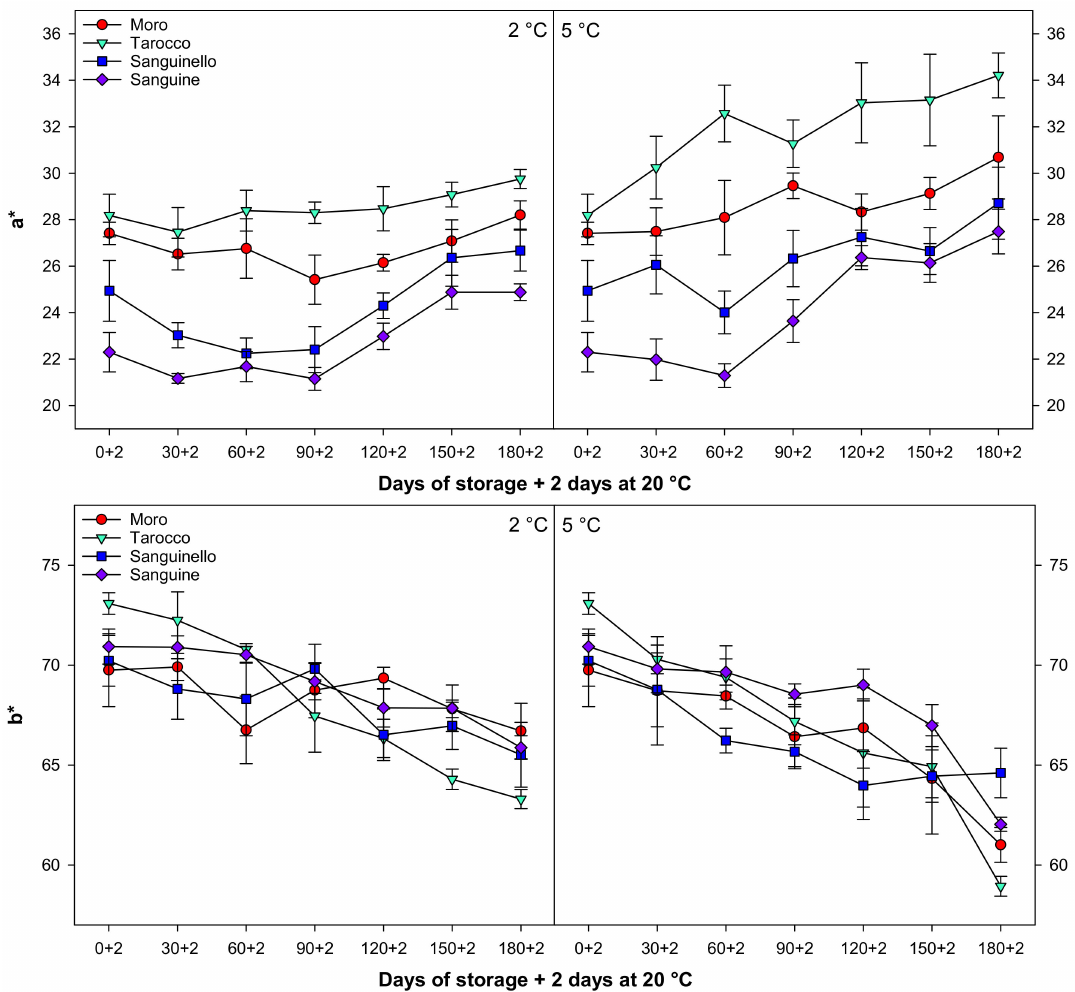
Figure 5. Changes in L*, a*, and b* of blood orange cultivars (‘Moro’, ‘Tarocco’, ‘Sanguinello’, and ‘Sanguine’) during cold storage at 2 and 5 ◦ C and 90% relative humidity (RH) plus 2 days at 20 ◦ C. Vertical bars represent ± standard error (SE) of means. LSD ( p < 0.05) values are 1.45, 1.26, and 1.33, respectively.